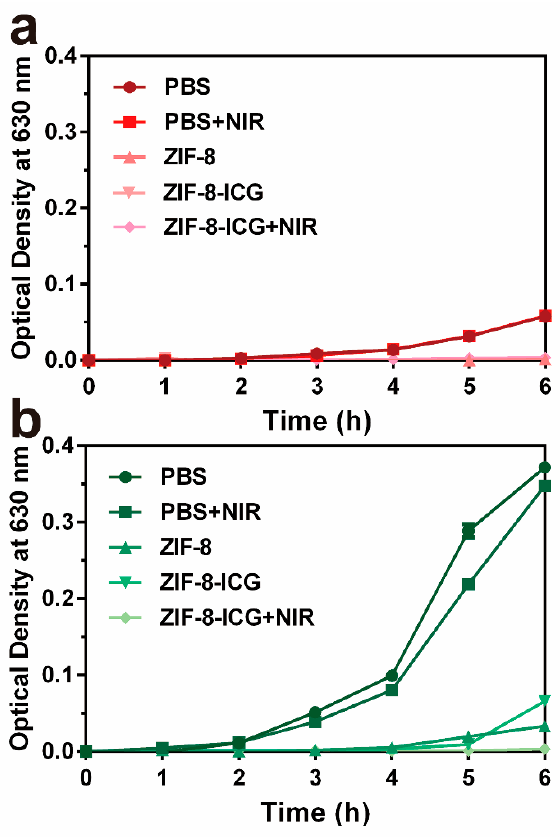
Figure 5. The growth kinetics curve of ( a ) MRSA and ( b ) P. aeruginosa with different treatments for 6 h at 37 °C.